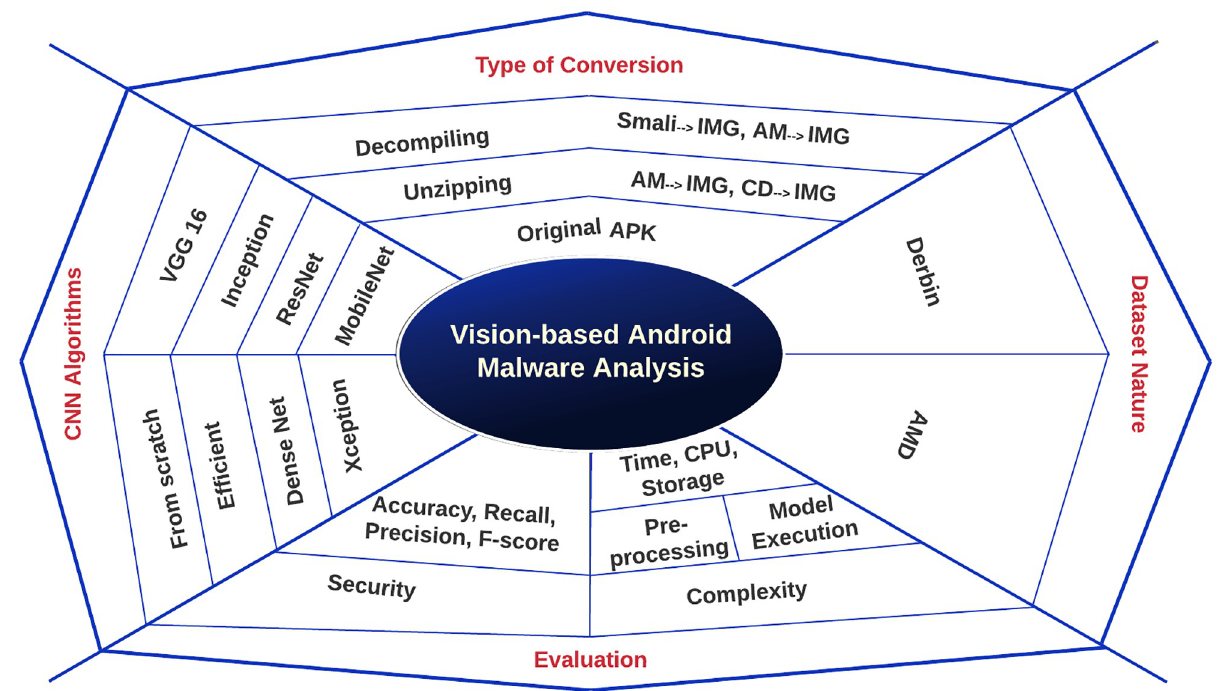
Fig 1. The high-level description of the in-detail processes in the proposed comprehensive